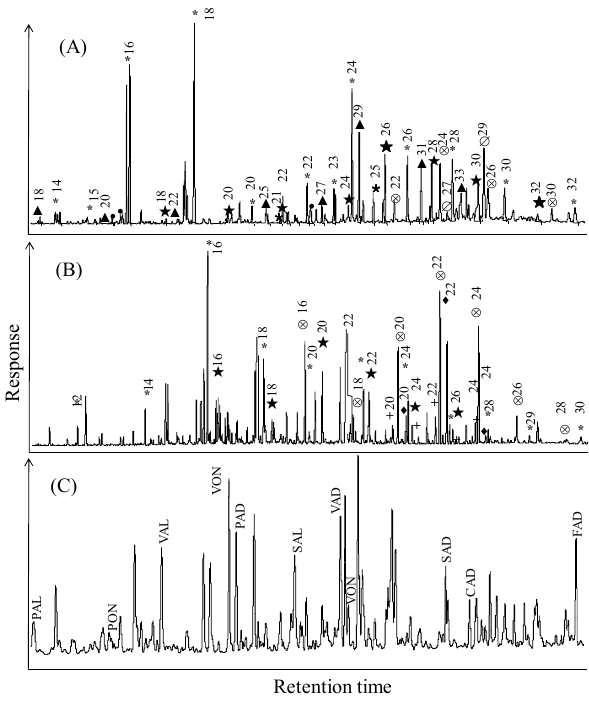
Fig. S2. Gas chromatograms of (A) solvent extractable fraction; (B) base hydrolysable Figure A2. Gas chromatograms of (a) solvent extractable fraction; fraction and (C) CuO oxidation products of grassland soils in Inner Mongolia, northern (b) base hydrolysable fraction and (c) CuO oxidation products of China. ▲: n -alkanes; ★ : n -alkanols; *: n -fatty acids (FA); ⊗ : ω -OH-FA; ∅ : sterols; • : grassland soils in Inner Mongolia, northern China: n -alkanes; ? : n - alkanols; *: n -fatty acids (FA); ⊗ : ω -OH-FA; ∅ : sterols; • : sugars; sugars; + : n -diacids (DA); ♦ : α-OH-FA. Numbers refer to total carbon numbers in individual biomarkers. Pal: p -Hydroxybenzaldehyde; Pon: p -Hydroxyacetophenone; + : n -diacids (DA); (cid:7) : α -OH-FA. Numbers refer to total carbon Pad: p -Hydroxybenzoic acid; Val: vanillin; Sal: syringaldehyde; Von: acetovanillone; numbers in individual biomarkers. Pal: p -Hydroxybenzaldehyde; Son: acetosyringone; Vad : vanillic acid; Sad: syringic acid; Cad: p -coumaric acid; Fad: Pon: p -Hydroxyacetophenone; Pad: p -Hydroxybenzoic acid; Val: ferulic acid. vanillin; Sal: syringaldehyde; Von: acetovanillone; Son: acetosy- ringone; Vad : vanillic acid; Sad: syringic acid; Cad: p -coumaric acid; Fad: ferulic